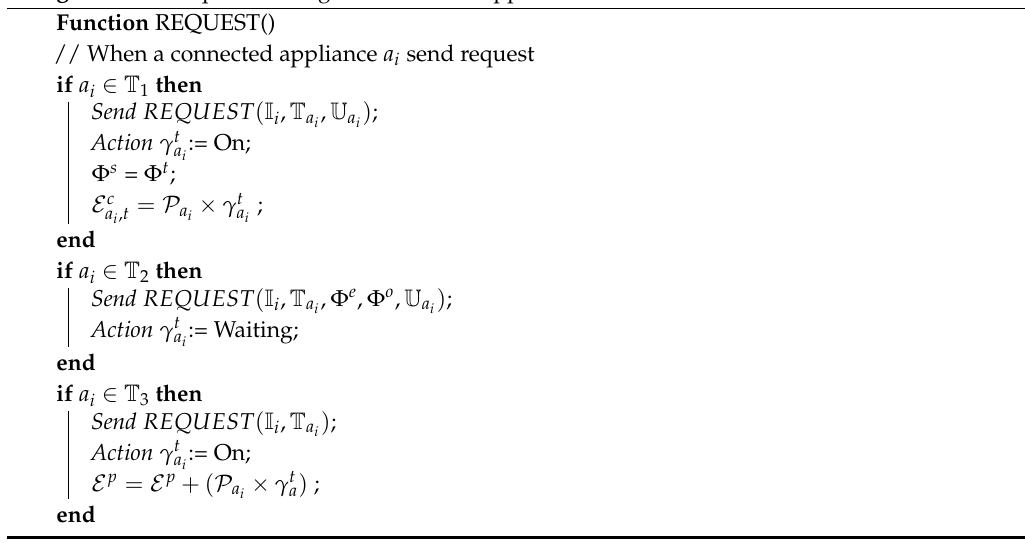
Algorithm 1: Request message of connected appliances